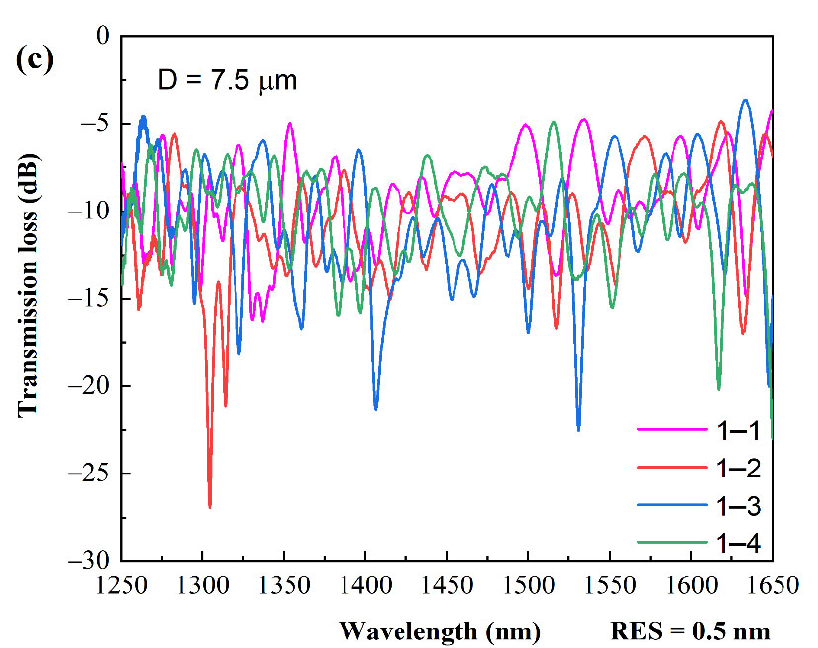
Figure 3. Spectral responses of the oscillating curves for: ( a ) D = 26 µ m, L = 1 mm; ( b ) D = 13.5 µ m, L = 2.18 mm; ( c ) D = 7.5 µ m, L = 2.21 mm in the 1–1/2/3/4 states.